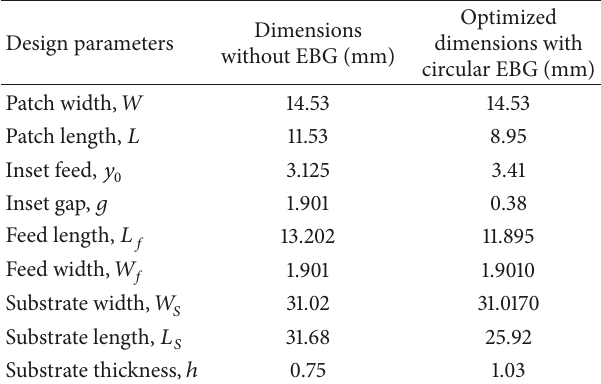
Table 1: Rectangular microstrip patch antenna